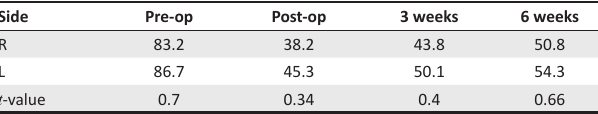
TABLE 4: Average grey scale values for the combined maxillae and mandibles of all the animals. Side Pre-op